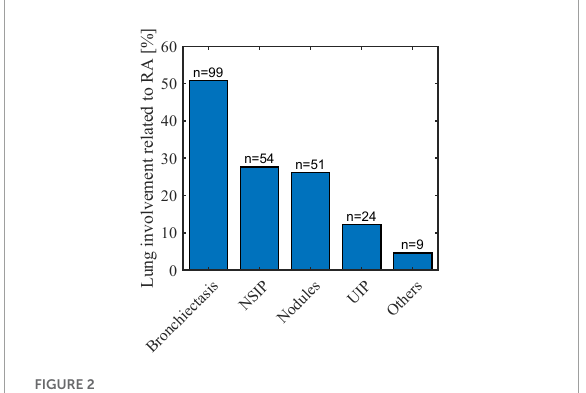
FIGURE2 Lung involvement related to RA. NSIP, non-specific interstitial pneumonia; UIP, usual interstitial pneumonia.